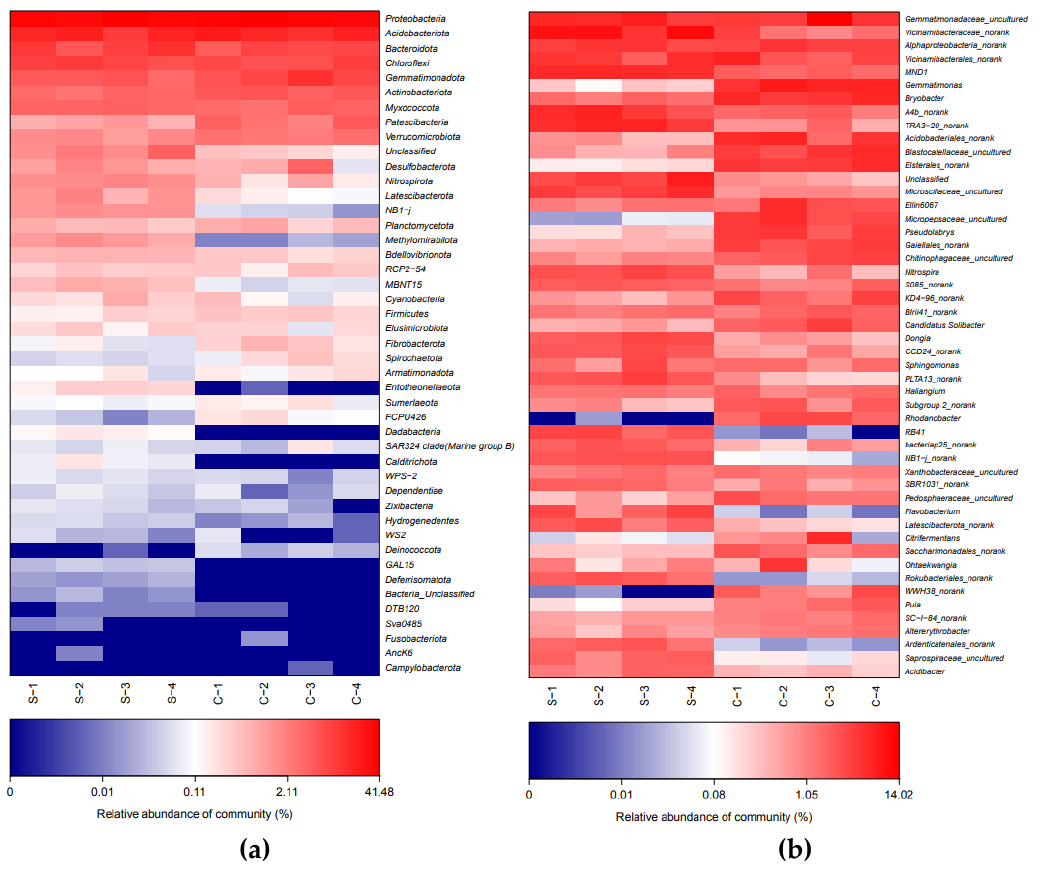
Figure 7. Microbial community heatmap analysis at the phylum ( a ) and genus ( b ) levels based on Bray–Curtis